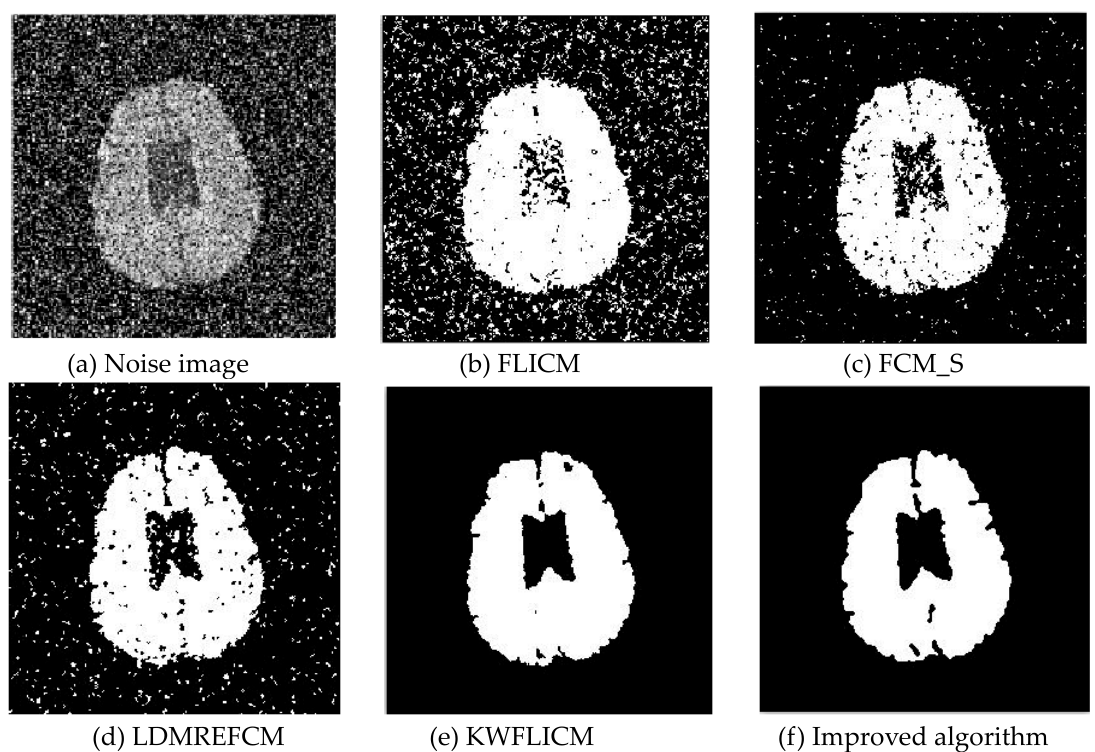
Figure 8. Salt-and-pepper noise interfering with brain slice images ( a ) and the segmentation results ( b – f ).